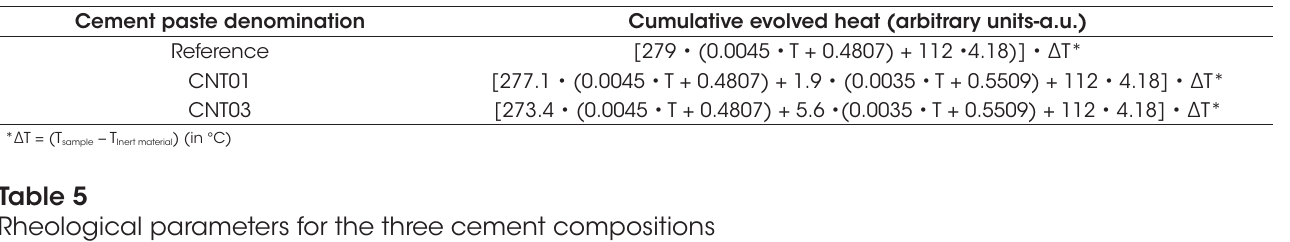
Cement paste denomination